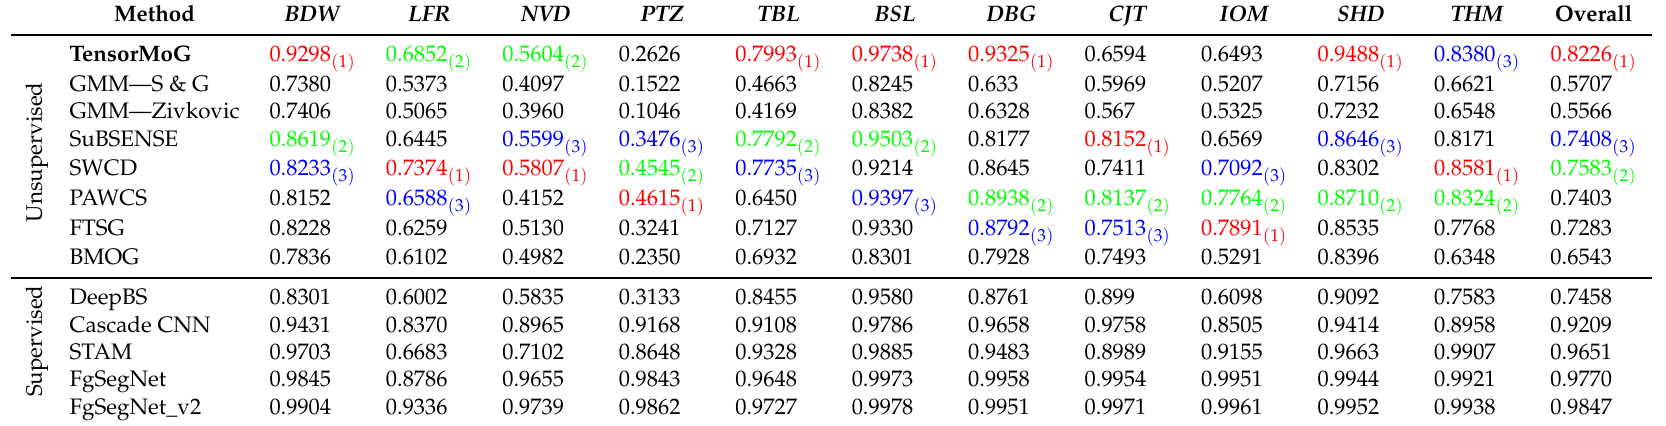
Table 2. F—measure comparisons over the 11 categories in the CDnet 2014